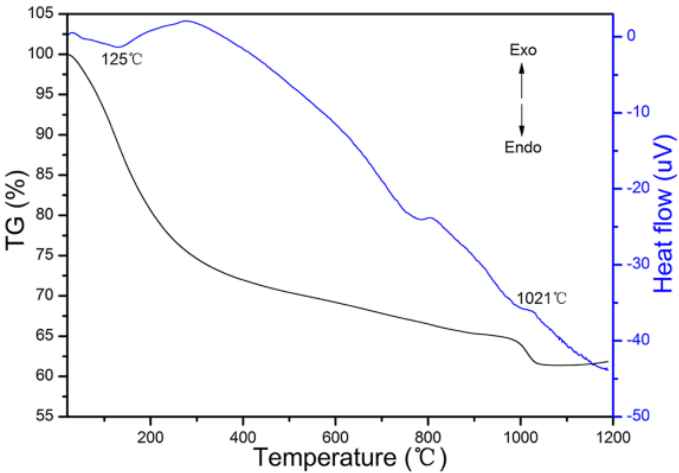
Figure 4. DTA-TG curves of the precursor of S7.